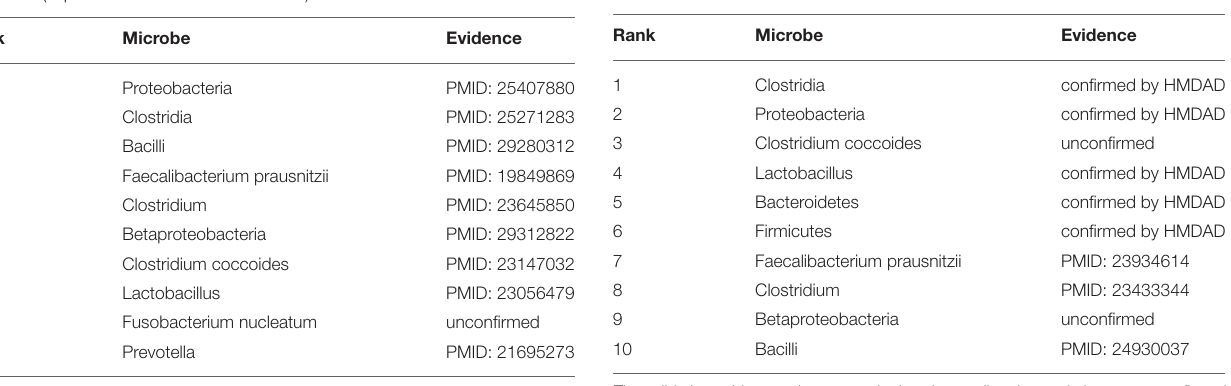
TABLE 3 | Prediction list of the top 10 potential type 1 diabetes-related microbes via removing all the known type 1 diabetes-microbe associations in HMDAD